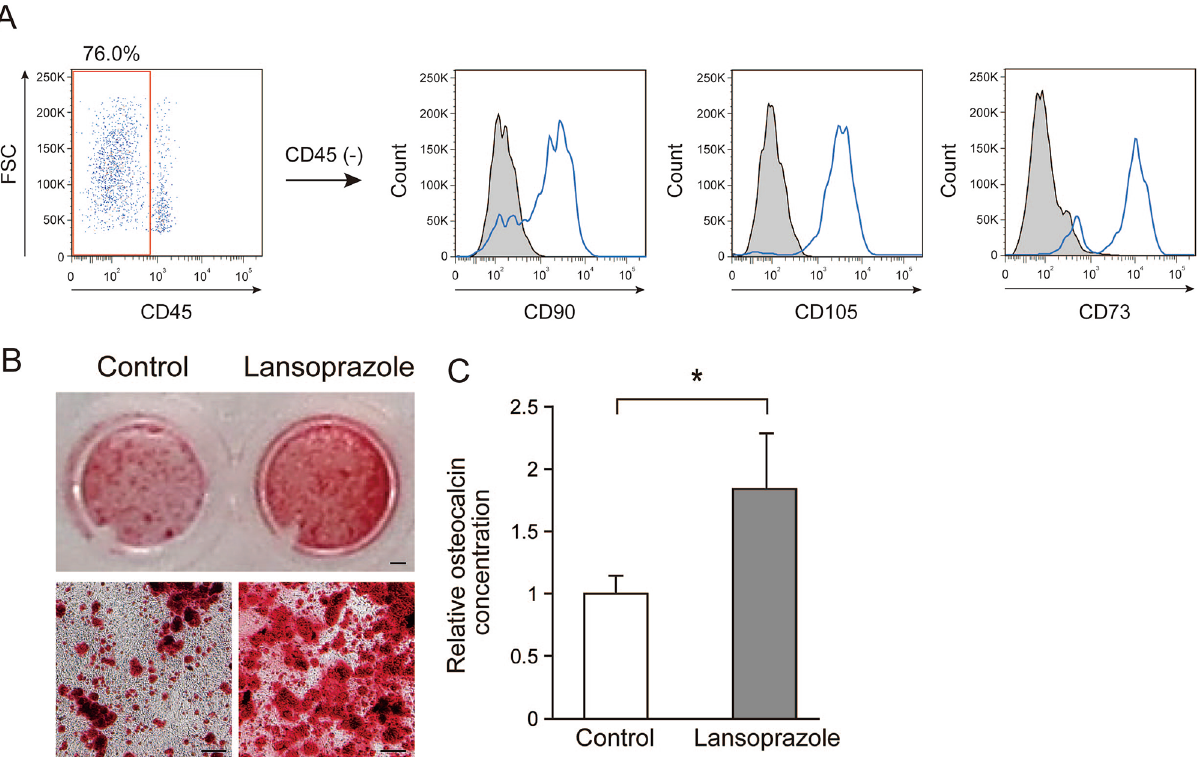
Figure 3. Short-term treatment with soluble lansoprazole enhances matrix calcium deposition of patient- derived bone marrow stromal cells (BMSCs). ( A ) Verification of stemness characteristics of plastic-adherent cells obtained from primary culture of patient-derived bone marrow aspirates in the growth medium. A pan-leukocyte marker CD45-negative adherent cells were evaluated for expression levels of typical MSC markers CD90, CD105, and CD73 by FACS analysis. Blue histograms show the fluorescent intensity for the indicated cell surface markers. Shadow histograms represent the fluorescent intensity obtained with the control antibodies. X-axis and Y-axis indicate fluorescent intensity and cell count, respectively. FSC, forward scatter. ( B ) Matrix calcium deposition detected by alizarin red staining in patient-derived BMSCs. Cells were treated with 20 µM of soluble lansoprazole for 1 day at the beginning of osteogenic induction and cultured for 21 days in the osteogenic medium without lansoprazole. Scale bar, 1 mm (upper panel) and 200 µm (lower panel). ( C ) Osteocalcin concentration of cell lysates of patient-derived BMSCs. Cells were treated with soluble lansoprazole for 1 day at the beginning of osteogenic induction and cultured for 14 days in the osteogenic medium without lansoprazole. The relative concentration was normalized to the mean of the control. The mean and SD ( n = 3) are indicated. * p < 0.05 by unpaired t